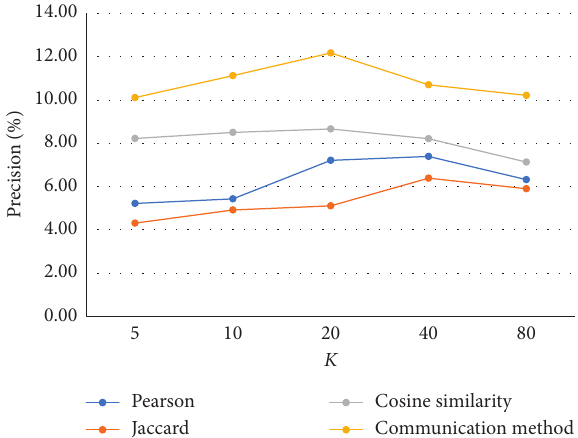
Figure 3: Precision of different user similarity calculation methods under multiple K values.